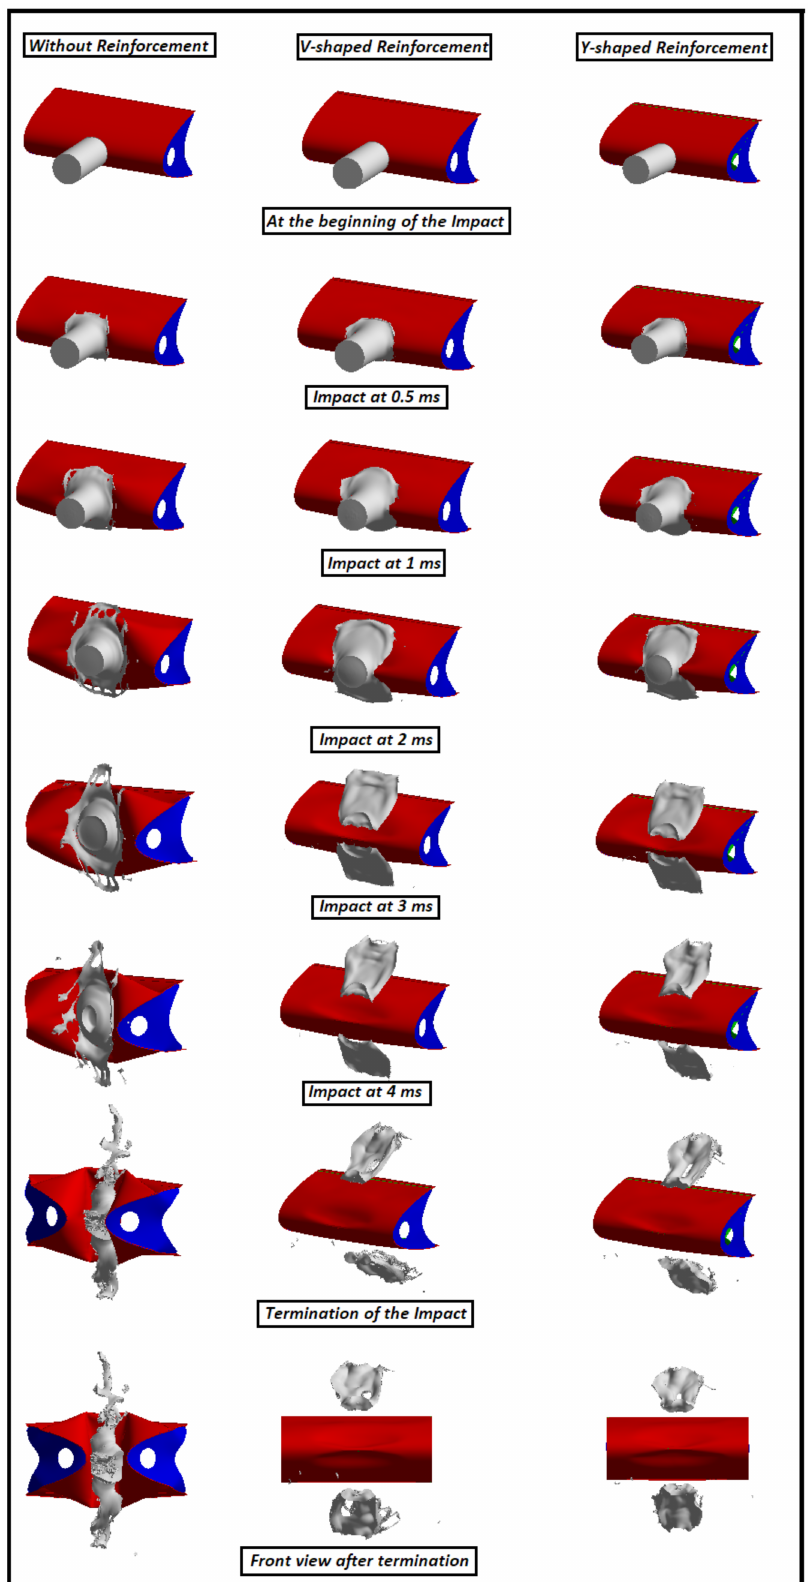
Figure 8. Bird projectile impact